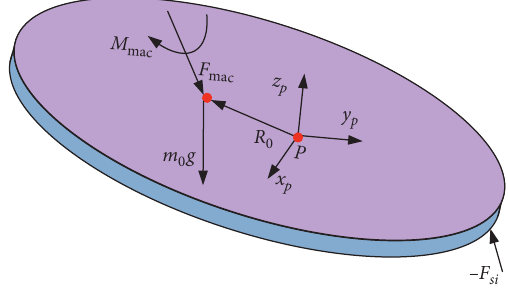
Figure 4: Force analysis diagram for the upper